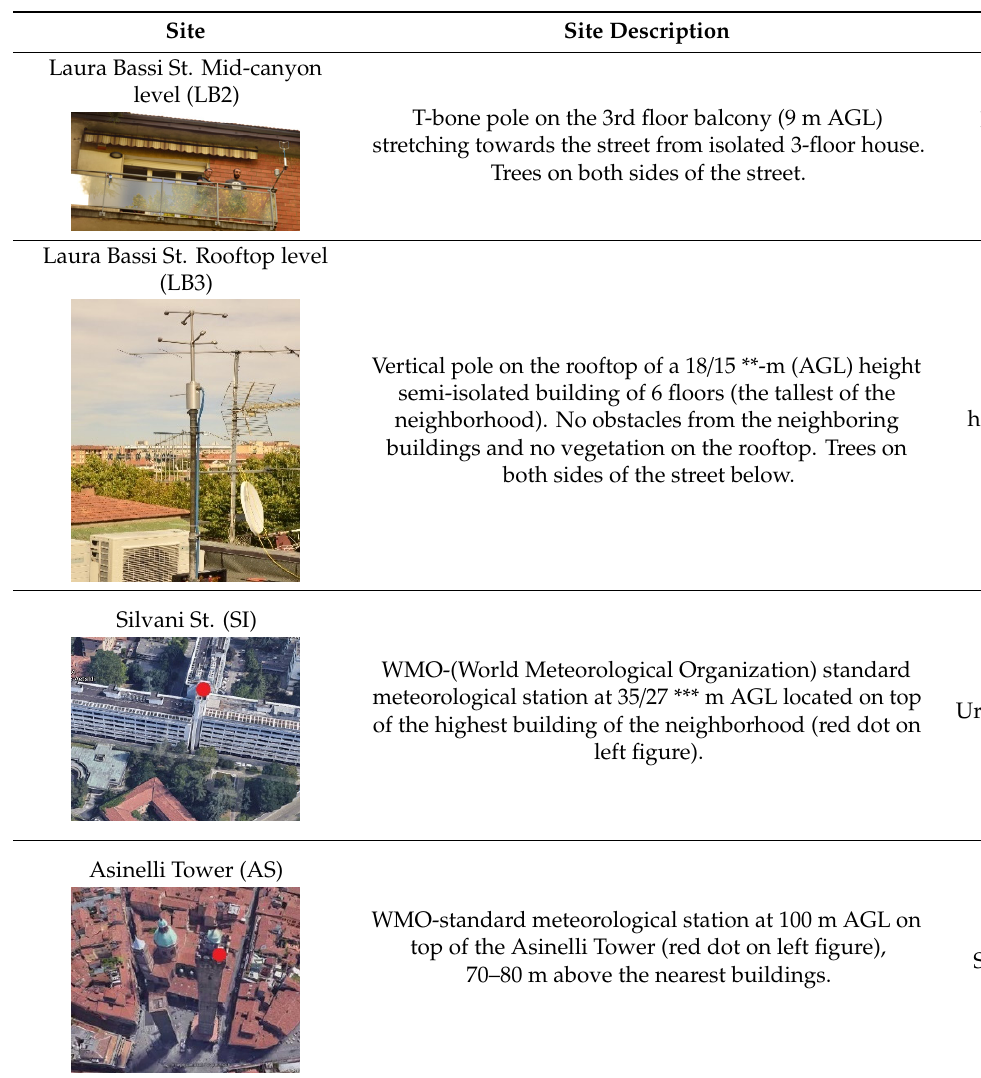
WMO-standard meteorological station at 100 m AGL on top of the Asinelli Tower (red dot on left figure), 70–80 m above the nearest